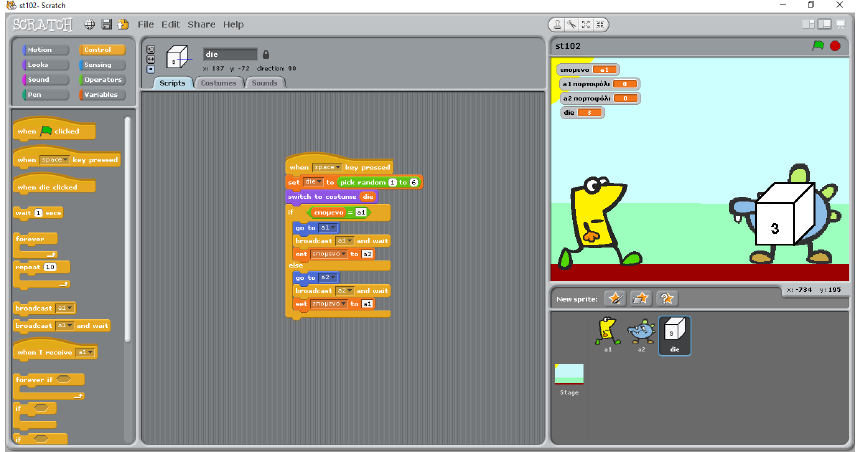
Fig. 2. Example of a final project by an average performing sixth grade student. The die script involves notifying the two players concerning whose turn it is. Notification was done by broadcasting and corrected to broadcast and wait by the teacher. This was necessary in order to block the dice script until players’ scripts finish. Without blocking there is a risk that the dice script will continue executing and perform the assignment that follows the broadcast, which changes players’ turn. Thus, a player could miss a